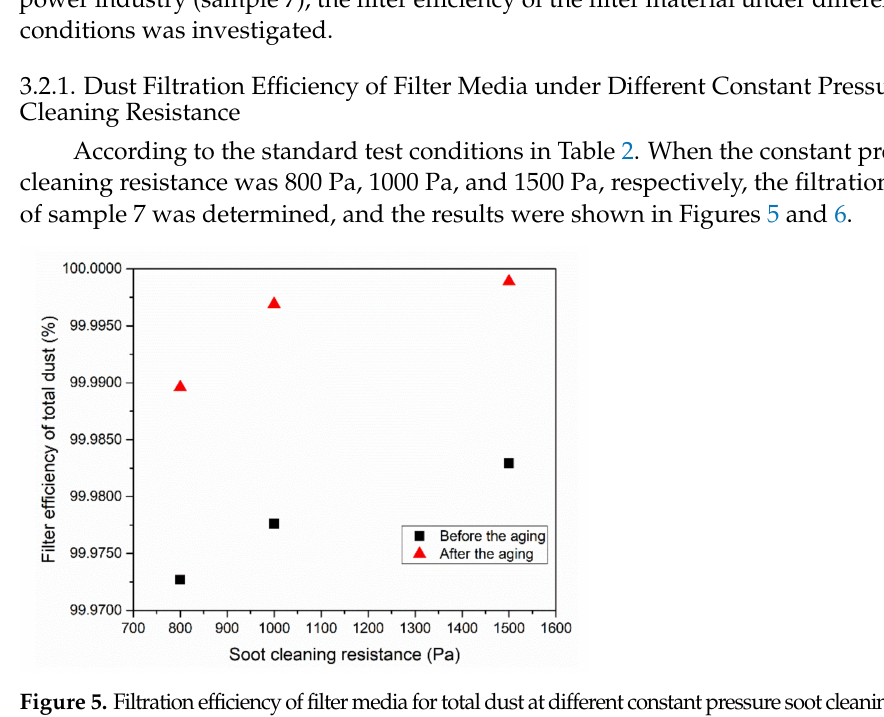
Figure 5. Filtrationefficiencyoffiltermediafortotaldustatdifferentconstantpressuresootcleaningresistances.